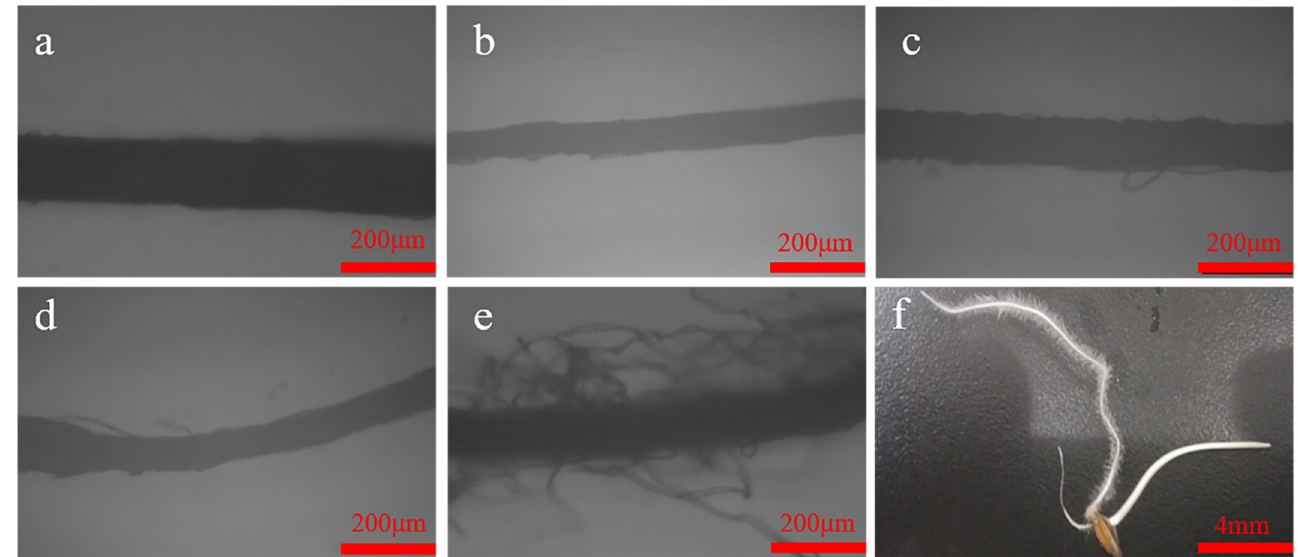
Figure 6. Light microscopic observation of L. multiflorum root hairs after 7 days exposure of DI ( a ); 23.8 mg/L KNO 3 ( b ); 40 mg/L Ag content of AgNO 3 ( c ); 40 mg/L Ag content of AgNPs ( d ); 40 mg/L Ag content of Ag@PDS ( e ); photo of fibrous root of L. multiflorum in 40 mg/L Ag content of Ag@PDS ( f ).